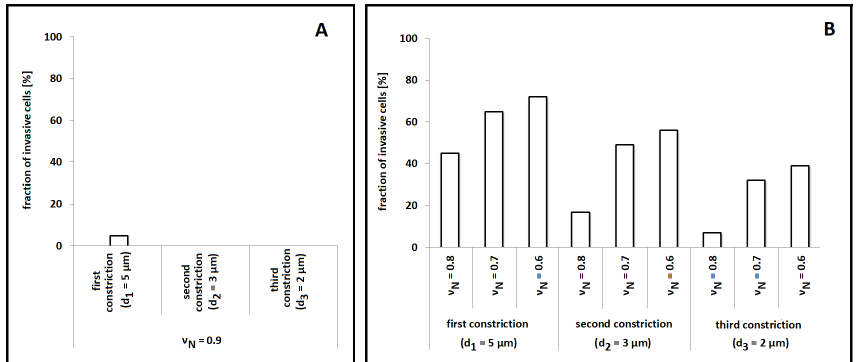
Figure 6. Quantification of chemotactic-driven cell migratory behavior in the case of the experimental setup used in [18]. ( A ) Percentage of cells that were able to overcome each constriction for the default value of the nucleus stiffness, i.e., for ν N = 0.9. ( B ) Percentage of cells that were able to overcome each constriction upon variations in the nuclear stiffness. Values were calculated over 100 numerical realizations. We remark that, in the simulation settings proposed in this paragraph, the initial diameter of the nucleus is d N = 16 µ m.